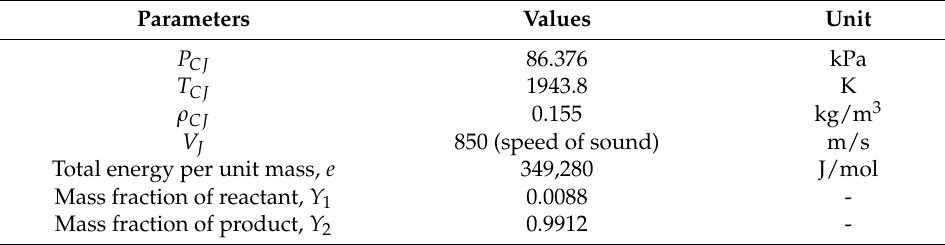
Table 2. Equilibrium CJ state of hot